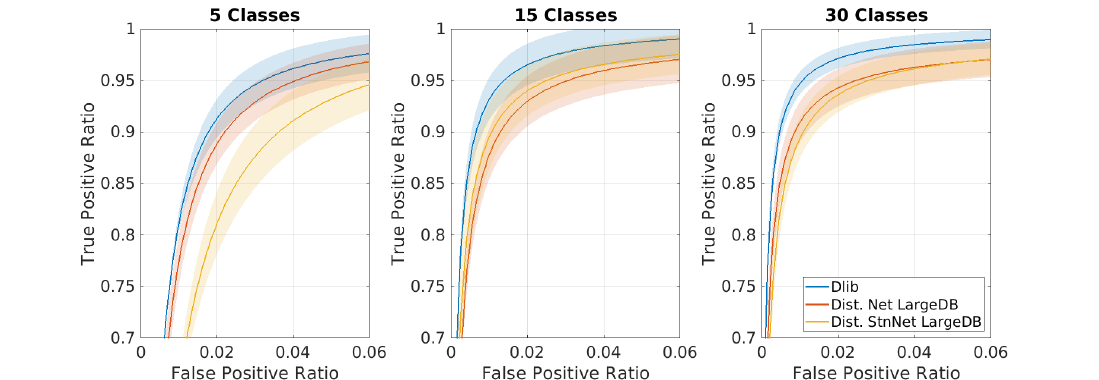
Figure 11. Average ROC curves estimated from a ten-fold cross-validation procedure on multiclass classifier. Each classifier is trained using a fixed amount of samples (15) and a varying number of classes, using the features generated by ’dlib-resnet-v1’, ’distilled-net’, ’distilled stn+net’. Note that the graphs are highly zoomed portions of the entire